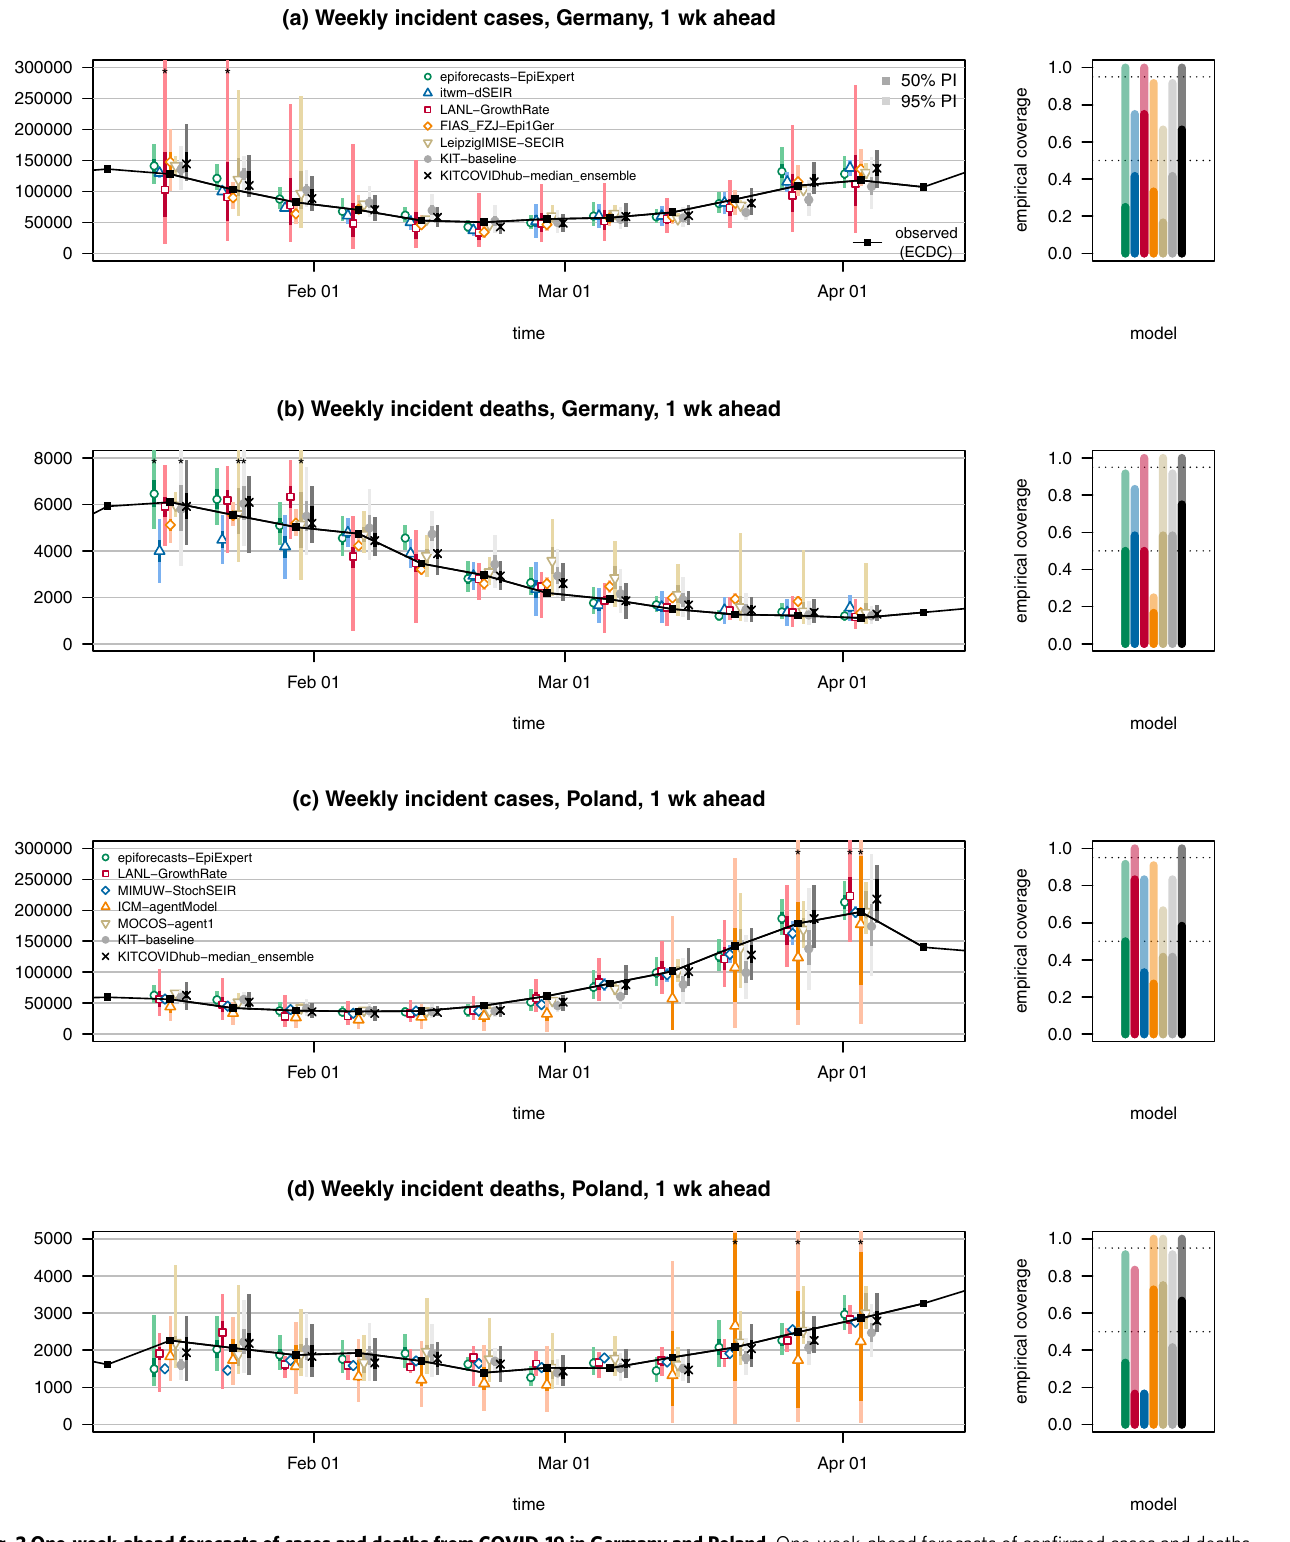
Fig. 2 One-week-ahead forecasts of cases and deaths from COVID-19 in Germany and Poland. One-week-ahead forecasts of con fi rmed cases and deaths from COVID-19 in Germany ( a , b ) and Poland ( c , d ). It shows forecasts from a baseline model, the median ensemble of all submissions, and a subset of submitted models with above-average performance. The black line shows observed data. Colored points represent predictive medians and dark and light bars show 50 and 95% prediction intervals, respectively. Asterisks mark intervals exceeding the upper plot limit. The remaining submitted models are displayed in Supplementary Fig. 1. The right column shows the empirical coverage rates of the different models. The dark and light bars represent the proportion of cases where the 50 and 95% prediction intervals, respectively, contained the observed values. The dotted lines show the desired nominal levels of 0.5 and